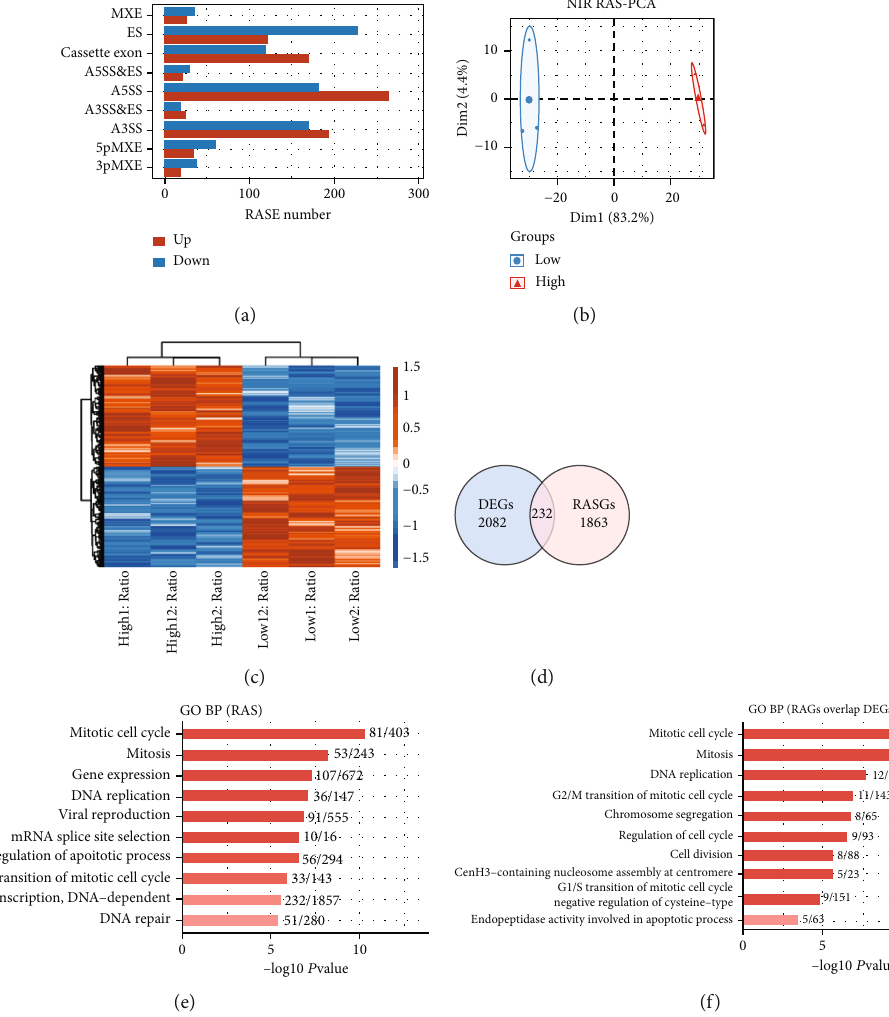
Figure 2: Transcriptome analysis of alternative splicing events (ASEs) in human retinal endothelial cells (HRECs) treated with hypoglycemia (LG) and hyperglycemia (HG). (a) Classi fi cation of all the regulated alternative splicing events (RASEs). X -axis: RASE number. (b) Principal component analysis (PCA) of LG and HG in HRECs based on PSI value of all di ff erent nonintron retention (NIR). The ellipse for each group is the con fi dence ellipse. (c) PSI heatmap of all NIR RASEs among HG samples compared to LG samples. AS fi ltered should have detectable splice junctions in all samples and at least 80% of samples should have ≥ 10 splice junction reads supporting the AS. (d) Venn diagram of DEGs and regulated alternative splicing genes (RASGs); p value = 1. (e) The GO analysis of RASGs in HG samples compared to LG samples. (f) The GO analysis of genes overlapped by DEGs and